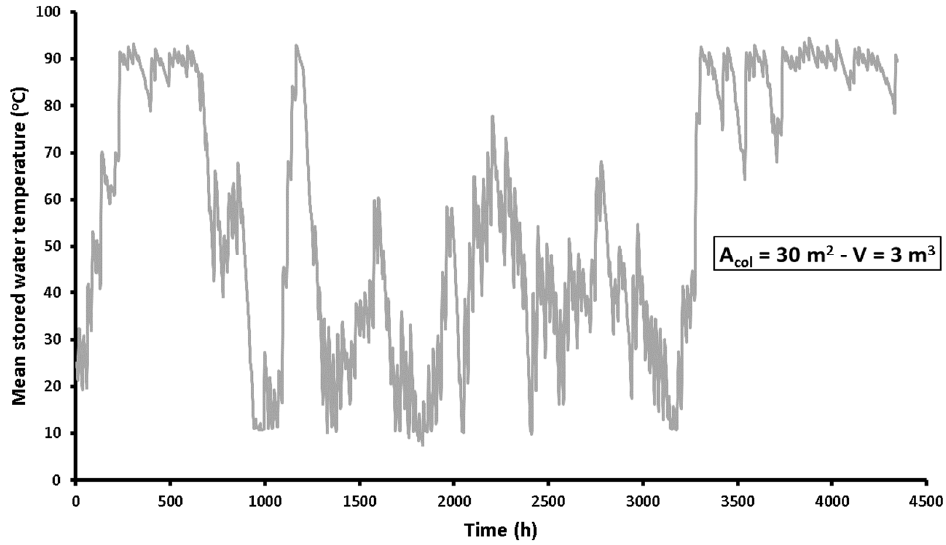
Figure 6. Mean water temperature in the storage tank for the case with 30 m 2 collecting area and 3 m 3 tank volume (1 October to 30 April).